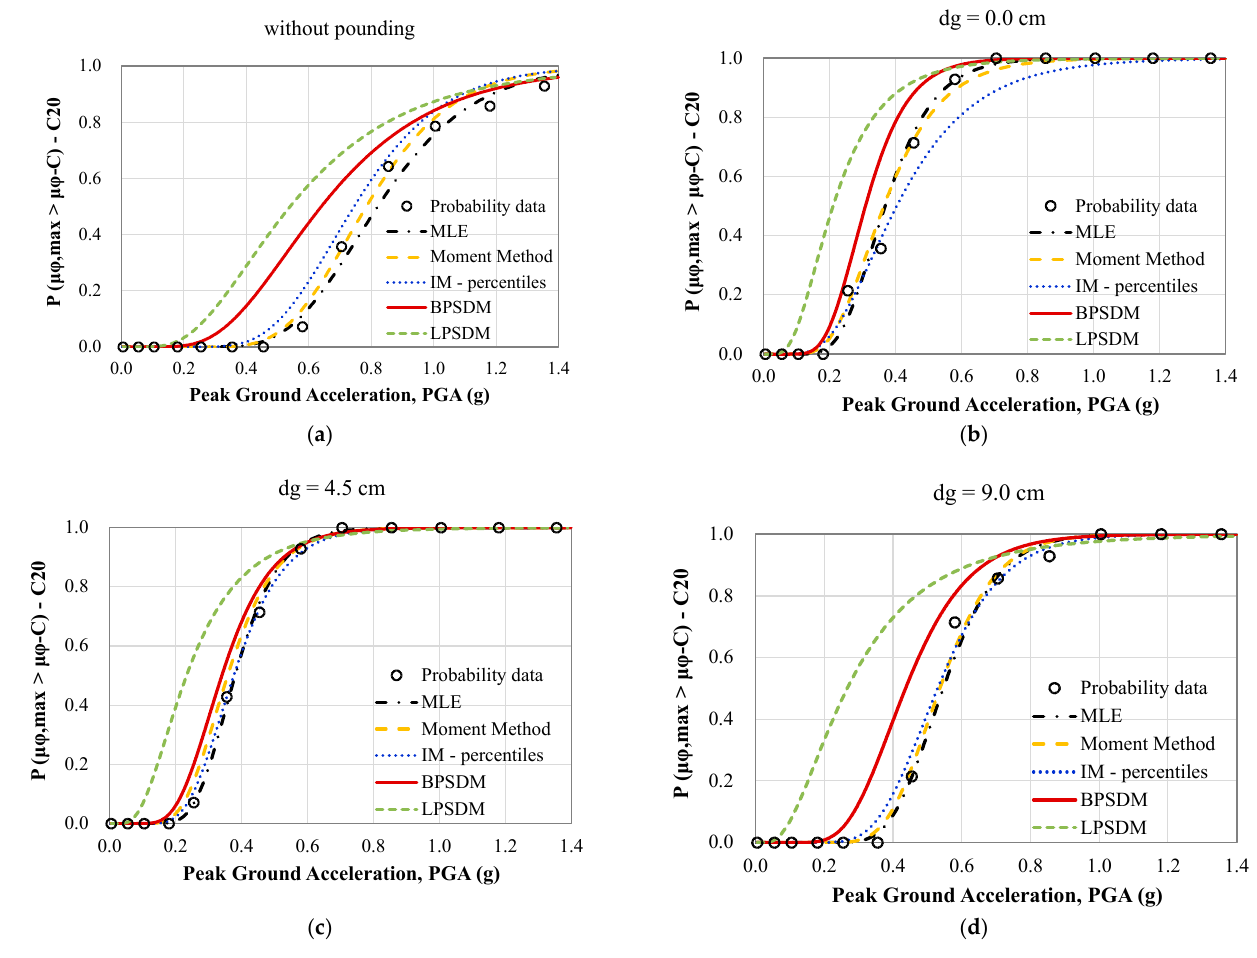
Figure 7. MLE, MM, IM percentiles, PSDM methodologies on the fragility assessment of the eight-story RC frame in terms of maximum curvature ductility μ φ ,max as a function of the PGA. Examined cases: ( a ) without the pounding effect, ( b ) d g = 0.0 cm, ( c ) d g = 4.5 cm, and ( d ) d g = 9.0 cm.